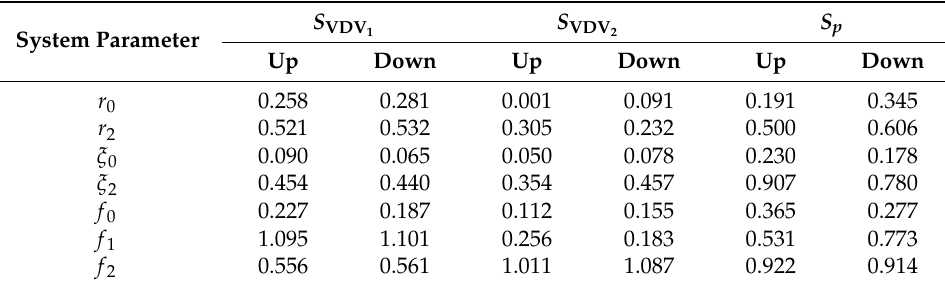
Table 7. The calculated results of the vibration response